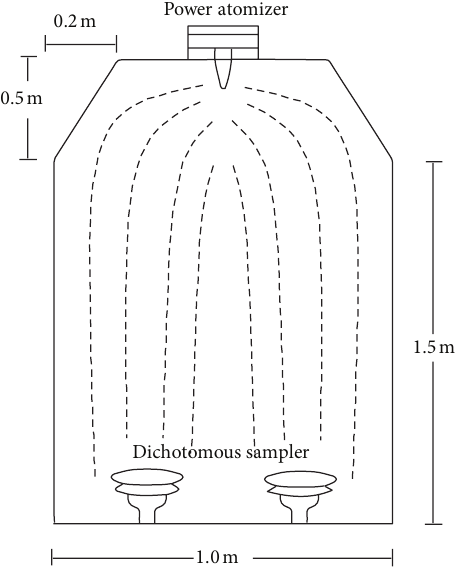
Figure 2: Schematic diagram of the resuspension